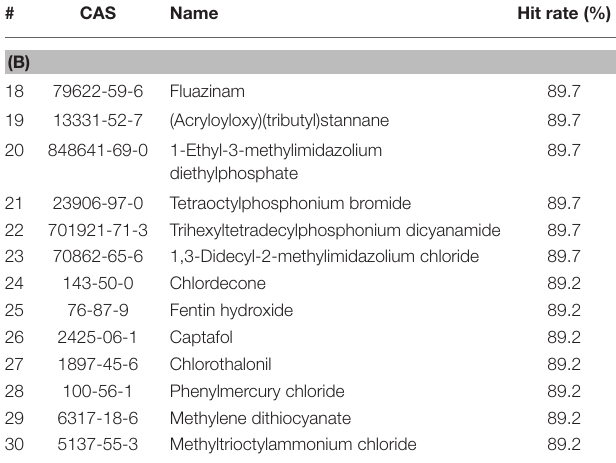
TABLE 1 | Top 30 most active (A) drugs and (B) ENVCs from Tox21 10K library screens based on hit rates against all